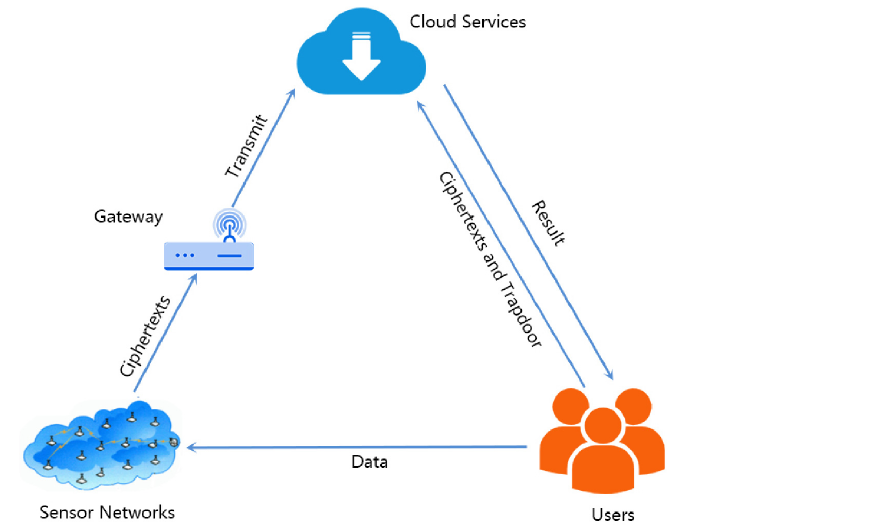
Fig 1. The framework of the mechanism